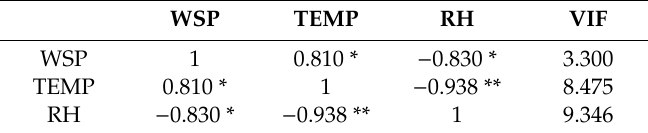
Table 6. Pearson correlations between climatic parameters.